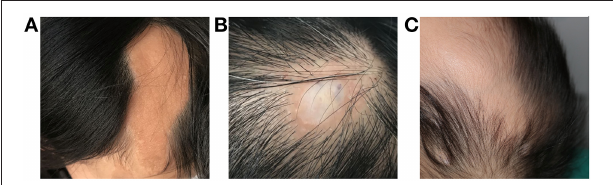
FIGURE 1 | Dermatological manifestations of patients with LNSS an OES-ECCL. Sebaceous nevus in a patient with LNSS (patient 4) (A) . Nevus psiloliparus (ECCL, patient 25) (B) and congenital alopecia (OES, patient 13) (C)